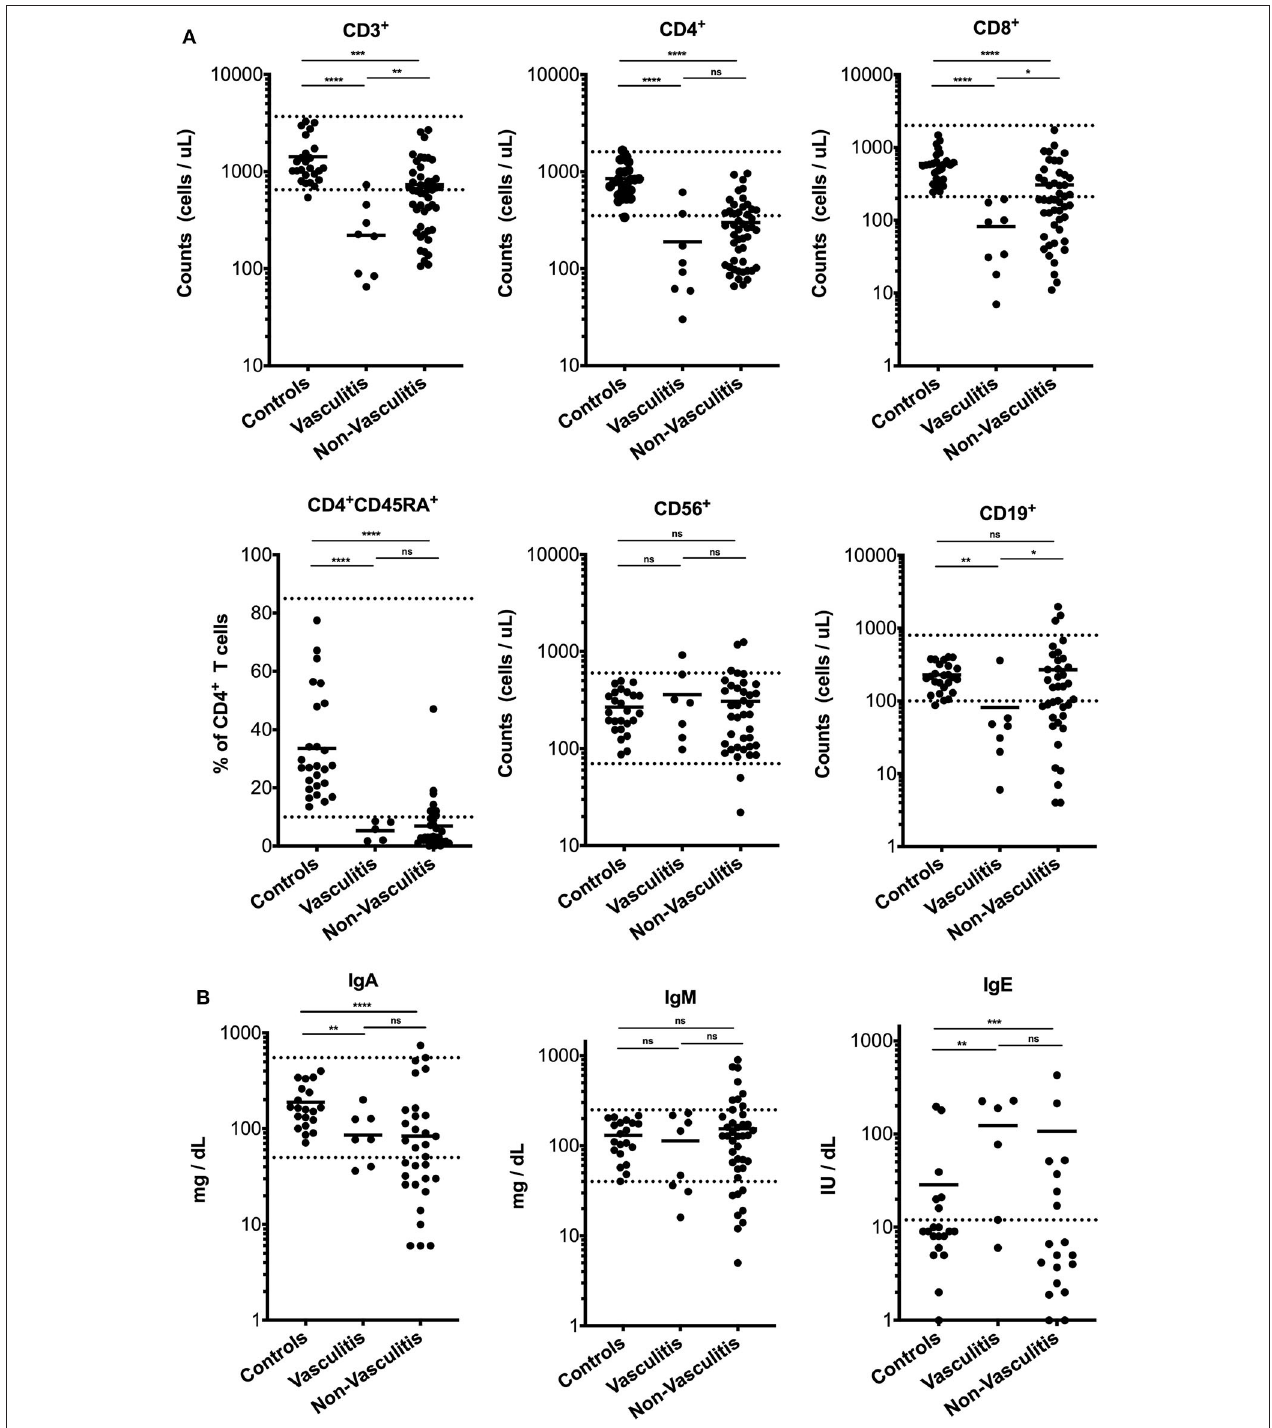
FIGURE 3 | Lymphocyte cell counts and serum immunoglobulins in patients with vasculitis due to RAG deficiency. (A) CD3 + T cells, CD4 + T cells, naïve CD4 + CD45RA + T cells, CD8 + T cells, CD56 + NK cells, and CD19 + B cells of age-matched healthy controls ( n = 25), RAG deficient patients with ( n = 8) without ( n = 46) vasculitis (B) Immunoglobulin titers of age-matched healthy controls ( n = 25) RAG deficient patients with ( n = 8) without ( n = 46) vasculitis. Dashed line represents normal values. Statistically significant differences obtained in intergroup comparisons were confirmed by Mann Whitney U -test. Values of p < 0.05 were considered as significant (ns statistically not significant, * p ≤ 0.05, ** p ≤ 0.01, *** p ≤ 0.001, **** p ≤ 0.0001).